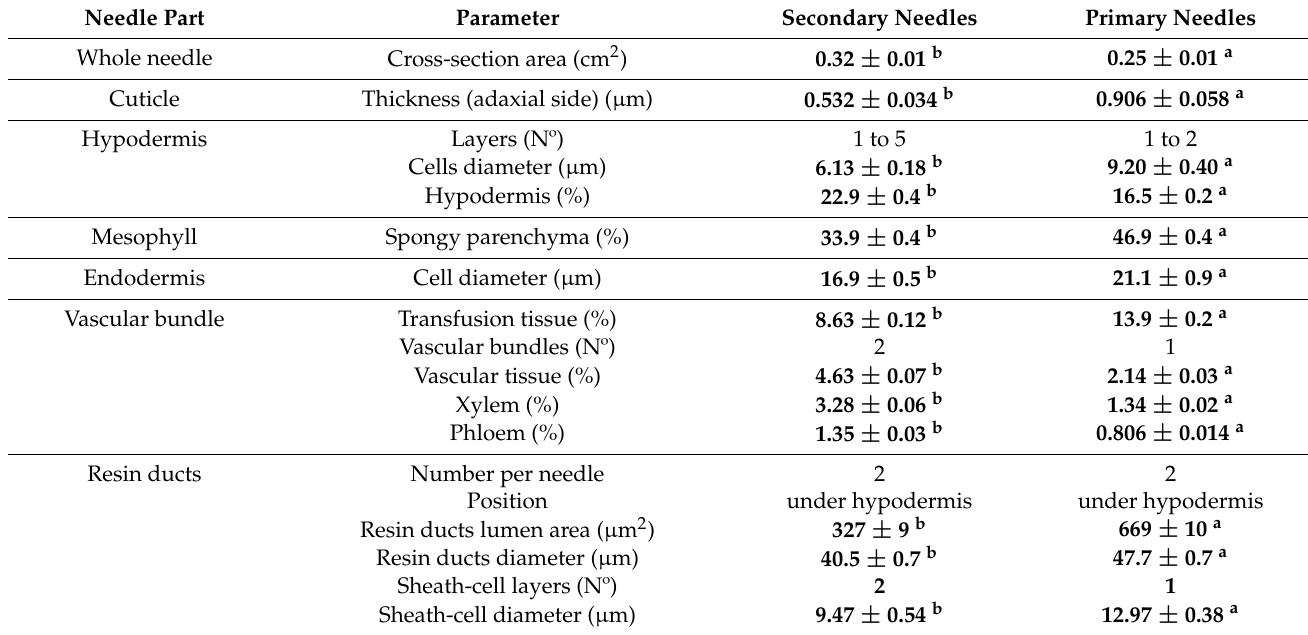
Table 2. Anatomical traits in secondary (adult) and primary (juvenile) needles estimated under the light microscope in stained cross-sections. Values are mean ± SE ( n = 20). Units are specified in brackets for each parameter. Percentages refer to total cross-section area. Values highlighted in bold with different letters depict significant differences between secondary (adult) and primary (juvenile) needles ( p <